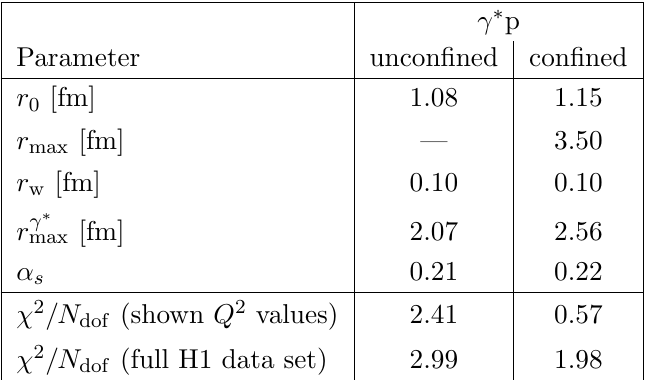
data set and the (cid:31) 2 obtained tot